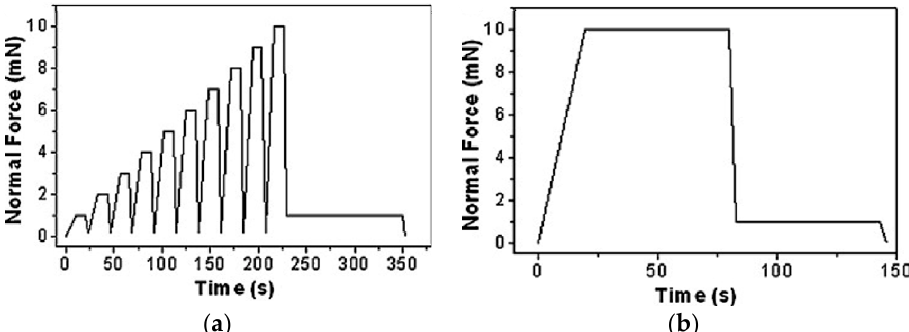
Figure 2. Set ‐ up of the second step of the calibration protocol used on Fq and Sa ( a ), and Pc ( b ). The normal force of the y ‐ axis corresponds to applied load.